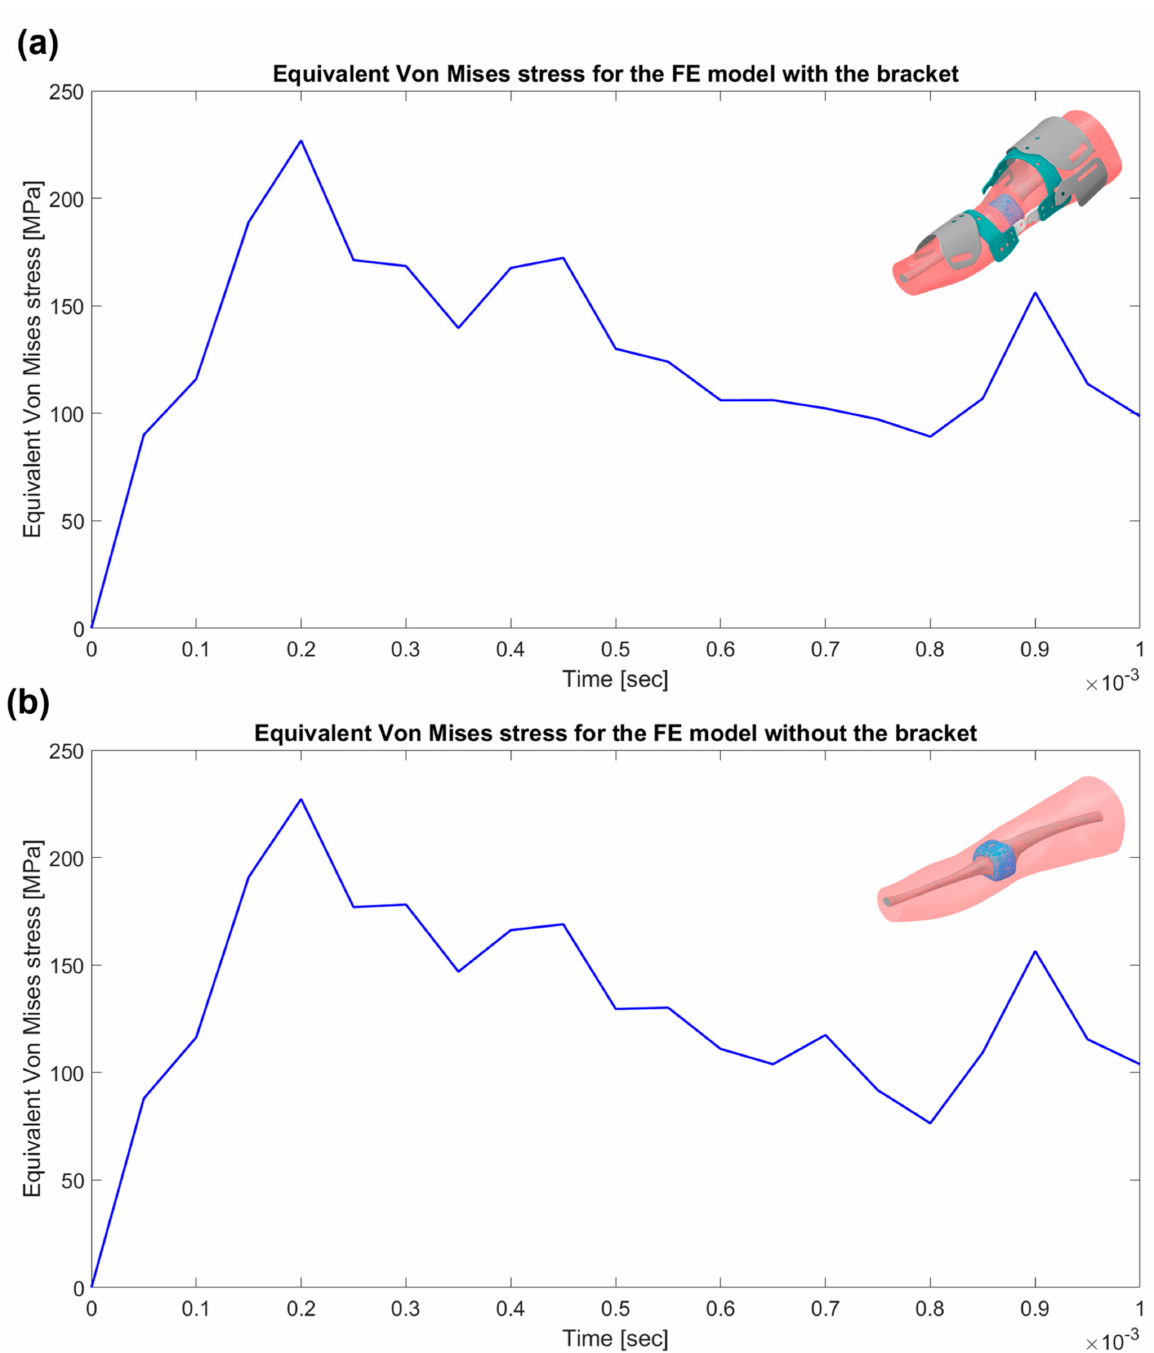
Figure 7. Maximum Equivalent Von Mises stress in the component of the limb for the ( a ) FE model with bracket and ( b ) FE model without